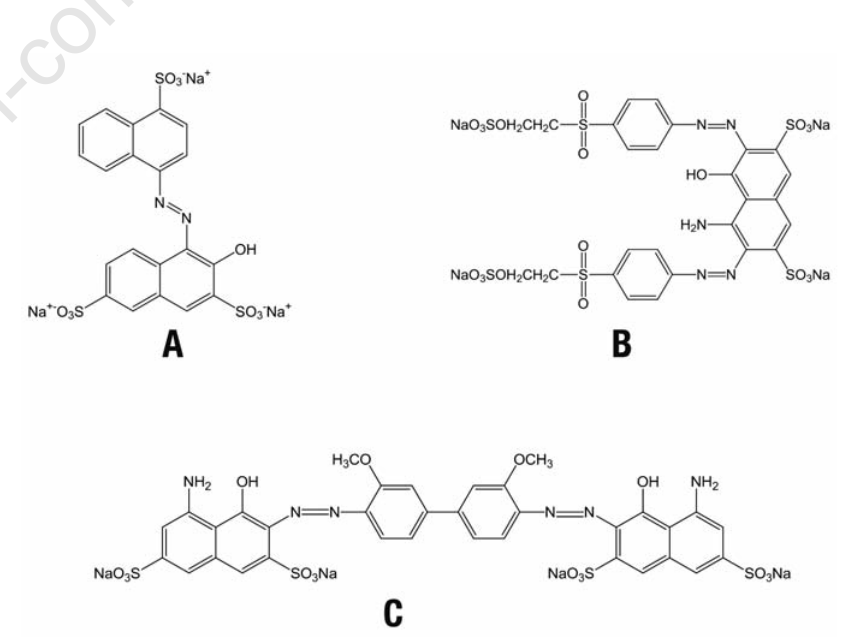
Figure 1. Structures of the azo dyes used in this study. A) Acid Red 27 (AR27), B) Reactive Black 5 (RB5), C) Direct Blue 15